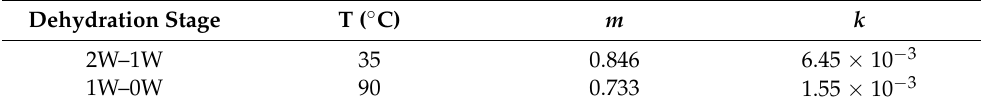
Table 3. Value of the rate constant ( k ) and parameter ( m ) for 2W–1W and 1W–0W transitions. Dehydration